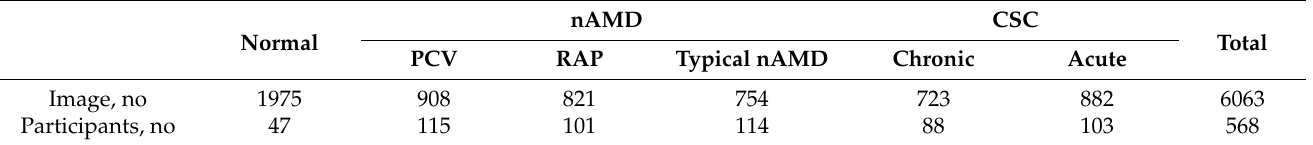
Table 1. Total SD–OCT